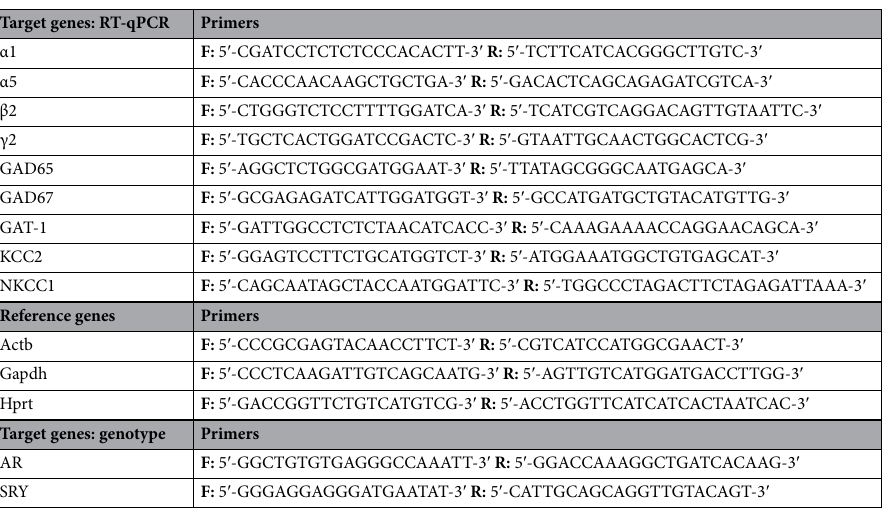
Table 1. Sequence of primers used in the RT-qPCR and